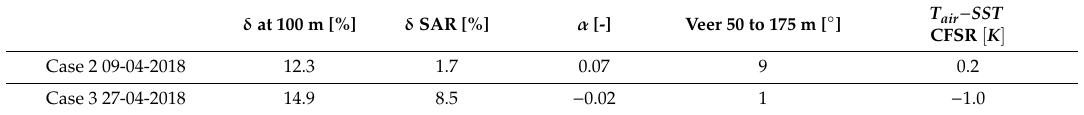
Table 2. Summary of averaged VD from Doppler radar and SAR together with the shear exponent, wind veer, and the air-sea temperature di ff erences as calculated from CFSR. δ at 100 m [%] δ SAR [%] α [-] Veer 50 to 175 m [ ◦ ] T air 12.3 0.07 0.2